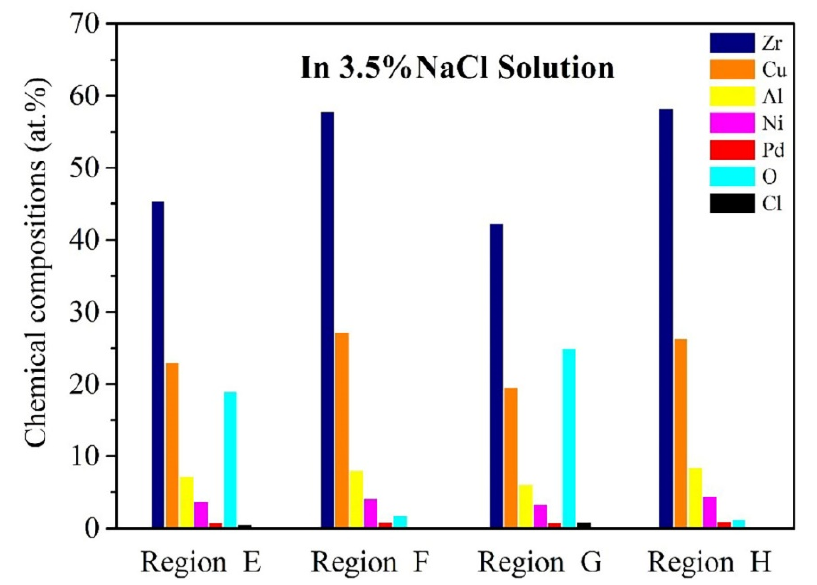
Figure 9. Chemical compositions of typical regions on the worn scar of as-cast and treated BMG in 3.5% NaCl solution respectively.